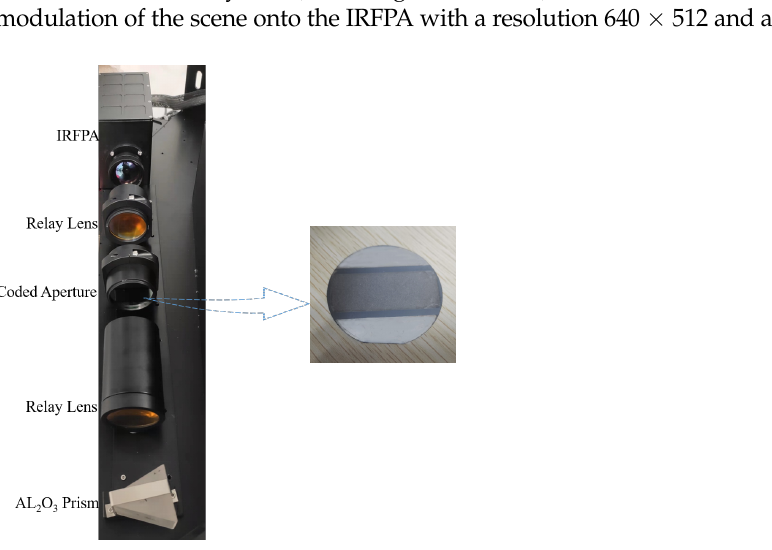
Figure 12. Experiment setup implemented in the